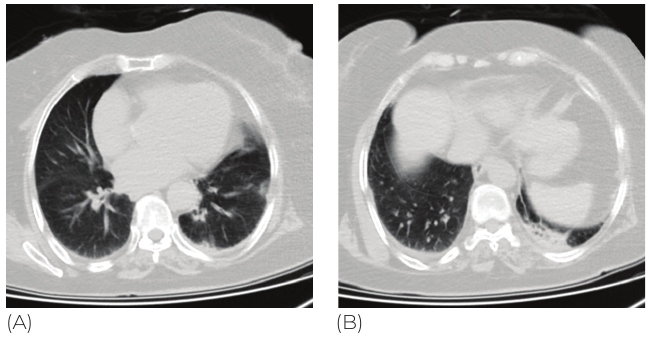
Figure 1. In the left inferior thorax lobe, there were two areas showing the ground glass opacities (A), in the lower area of ground glass opacities , these is crazy-paving pattern (B)